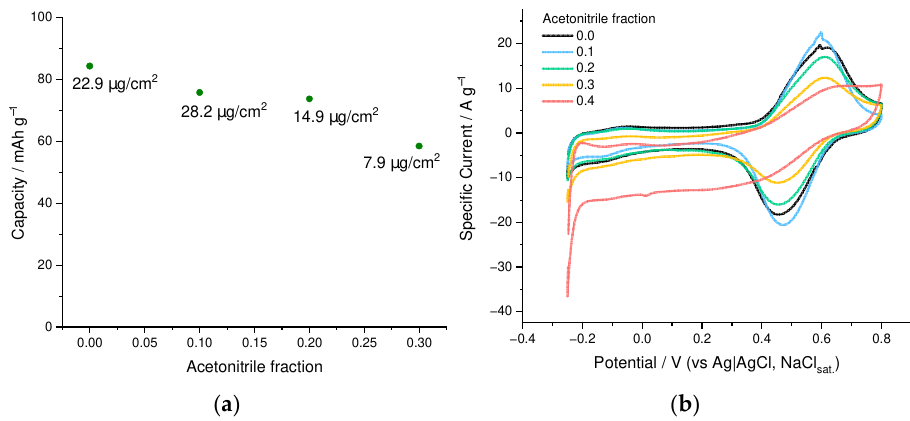
Figure 4. ( a ) Gravimetric capacity and areal loading vs. CH 3 CN fraction in the deposition electrolyte and ( b ) CV curves (20 mV·s −1 , 0.1 mM HClO 4 /H 2 O) of PEDOT:SPVC films; deposited from 5 mM EDOT + 10 mM NaSPVC solutions with different CH 3 CN fraction.